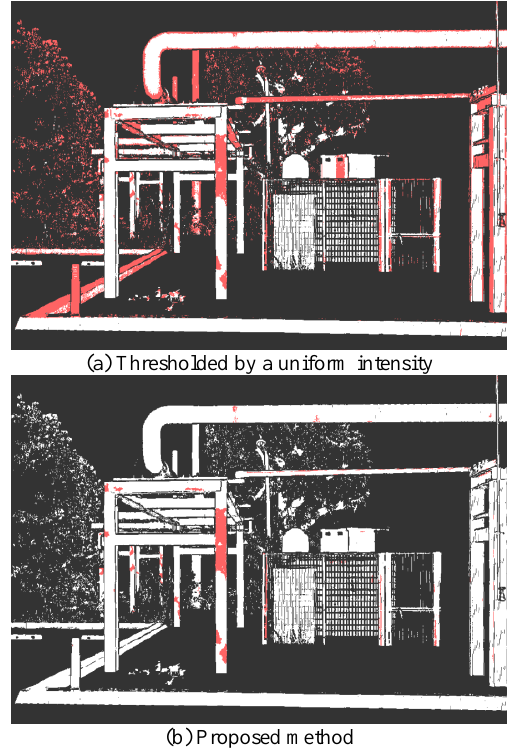
Figure 8. Detection result based on intensity. Anomaly points are colored in